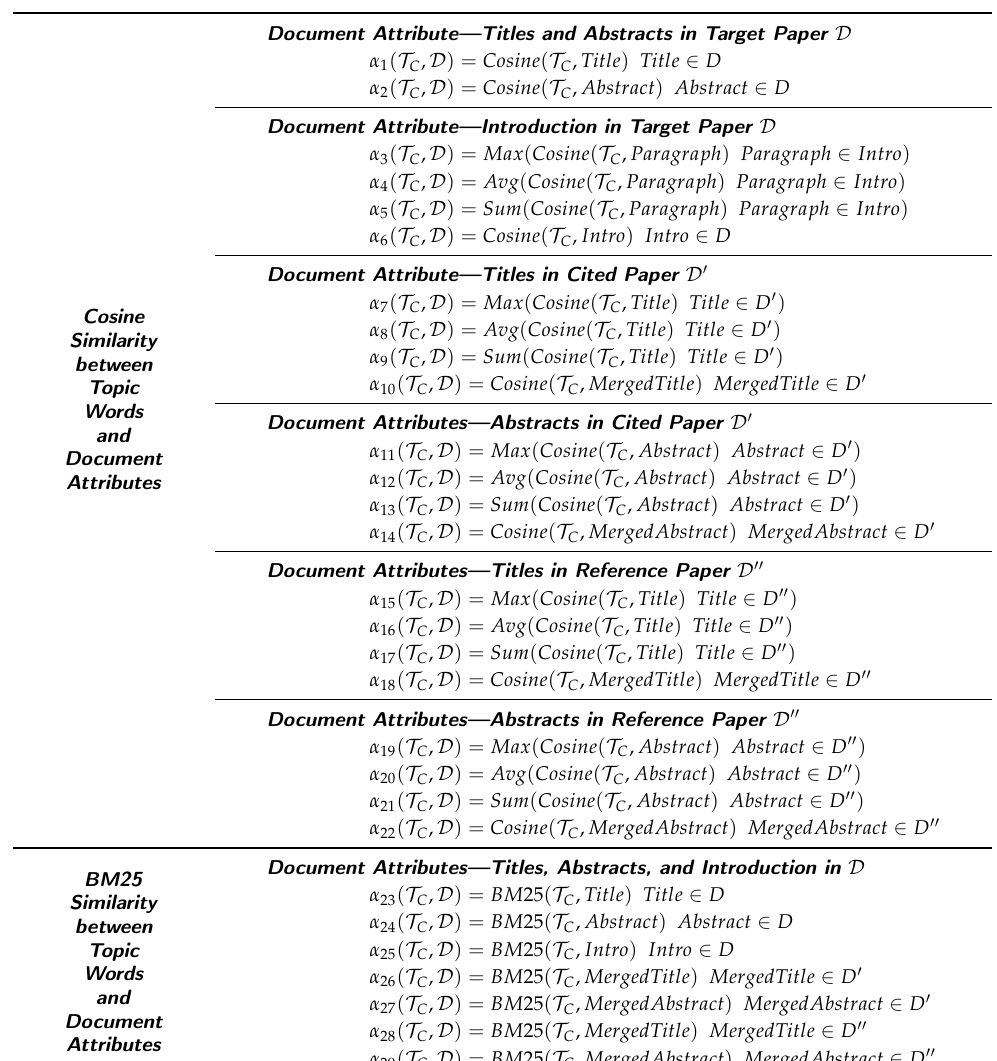
Table 3. The similarity between topic words and document